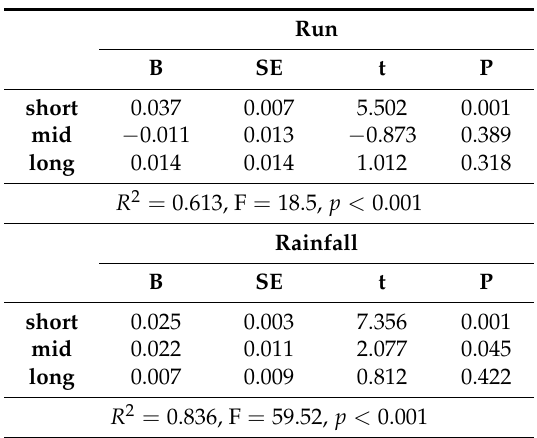
Table 5. Results of the regression